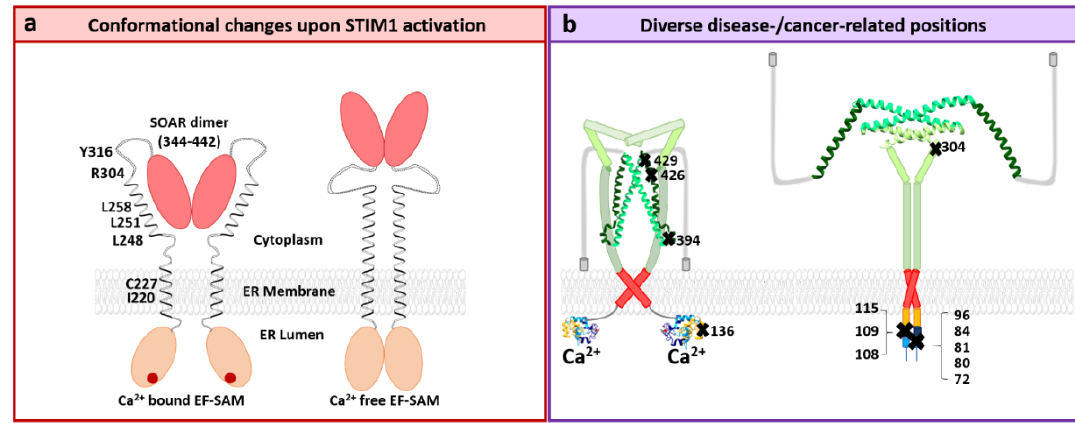
Figure 6. STIM1 activation and diverse positions related to diseases. ( a ) Cartoon representation of STIM1 dimer in the inactive state (left) and activated state (right). In the inactive state, the EF-SAM domains are both loaded with Ca 2+ ions and do not display any interaction. The transmembrane (TM) helices that connect the N-terminus of STIM1 to the C-terminus in the cytoplasm are spatially separated. The CC1 region displays an “inhibitory helix pocket” with important residues maintaining the STIM1 quiescent state highlighted. SOAR, comprised of residues 344–442, forms intramolecular interactions with CC1. In the activated state (right), the SOAR region decouples from CC1 and is exposed, the EF-SAM domains interact and the transmembrane helices moving closer to another (modified according to Hirve et al. [163]). ( b ) Diverse positions within the STIM1 protein leading to either loss of function (left) or gain of function (right). The highlighted residues represent disease-related positions that can lead to immunodeficiencies, tubular aggregate myopathy, Stormorken syndrome, York platelets syndrome, or even cancer upon mutation.